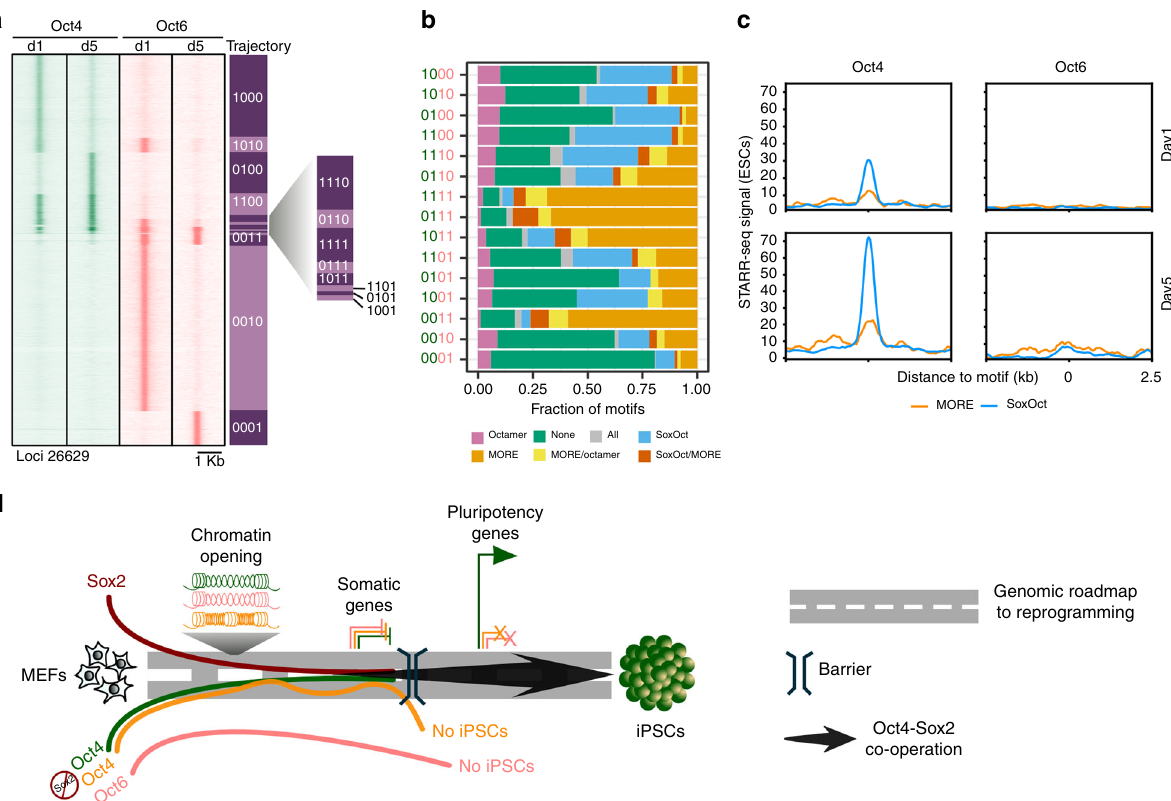
Fig. 6 Oct6 binds to alternative targets and avoids pluripotency enhancers. a Comparison of Oct4 (green color) and Oct6 (salmon color) ChIP-seq signals at days 1 and 5 of reprogramming. Rows are 15 occupancy trajectories de fi ned by the presence or absence of Oct4 or Oct6 peaks at day 1 or 5 (1 = binding, 0 = absence of binding). The summits were merged if they were within 100 bp. Genomic locations are provided in Supplementary Data 2. b Fraction of POU motifs mapping to binding sites in each of the occupancy trajectories. c Read pileup plots of STARR-seq signal (enhancer activity) in ESCs at Oct4 (left) and Oct6 (right) binding sites at days 1 (up) and 5 (bottom) of reprogramming containing either SoxOct or MORE motifs. d Model for unique and dispensable roles of Oct4 at different stages of somatic cell